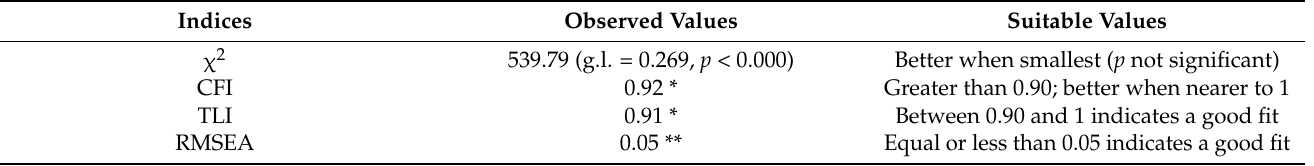
Table 6. Goodness-of-fit indices of the